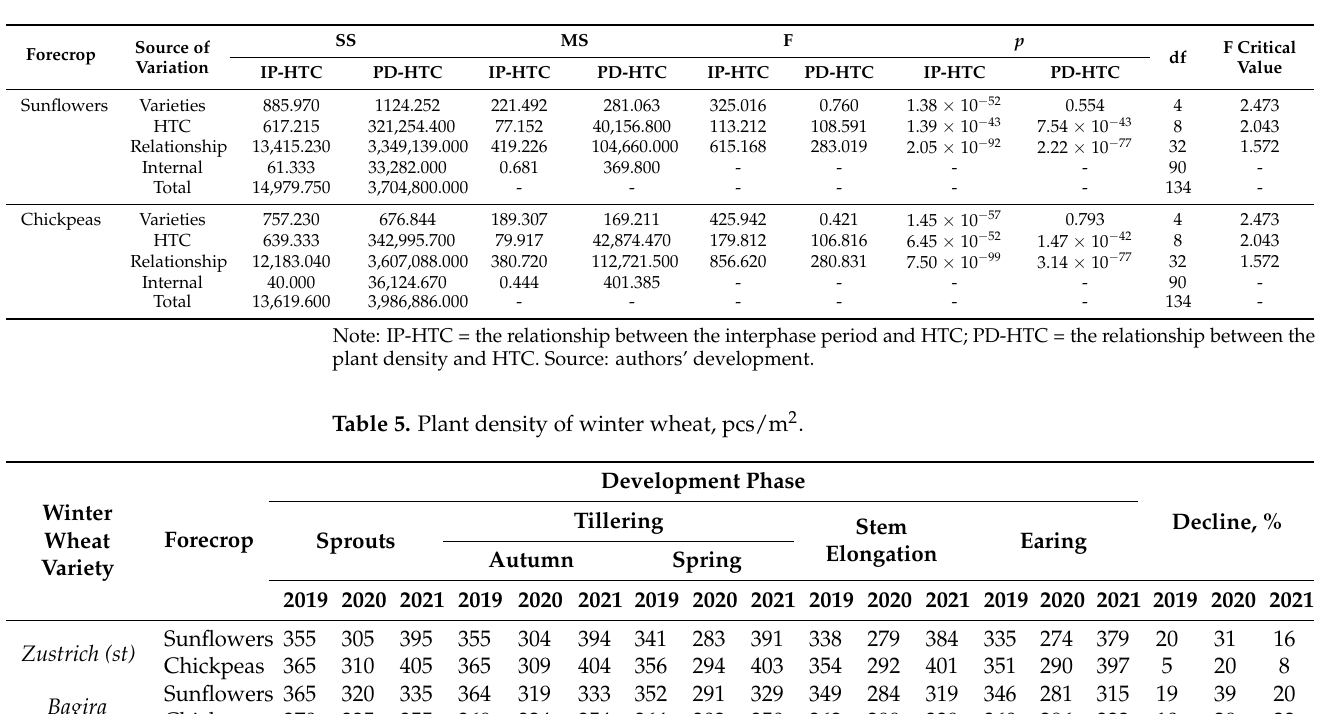
Table 4. The two-factor ANOVA results in 2019–2021.